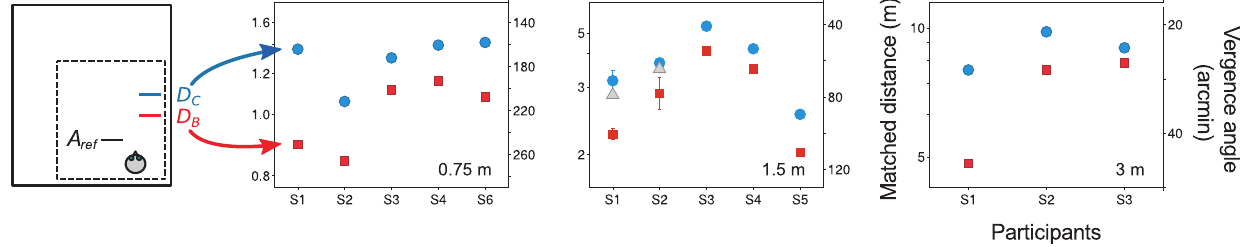
Figure 4. Dual perceived distances of an object. Red squares show the interpolated PSEs at which the comparison square D was perceived to be at the same distance as the reference square A when this was judged via an intermediate square B (shown as perceived distance or corresponding vergence angle). Blue circles show the equivalent PSEs when the intermediate object was square C. Data are shown for five participants when reference square A was at 0.75 m and 1.5 m and for three participants at 3 m. Error bars showing standard deviations are shown for four points at 1.5 m (see Procedures S2). For two participants (S1 and S2), PSEs obtained for a direct comparison between reference square A and comparison square D are shown as the grey triangles in the middle panel (see Procedures S2). The PSEs used for the interpolated values presented here are shown in Figure S2.